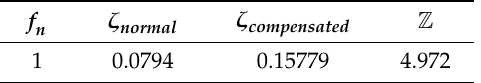
Table 2. Body and wing critical parameters [Speed = 0.52 kts, R e = 10 4 and 𝛼 (cid:3028)(cid:3047)(cid:3047) = 3.3° ].